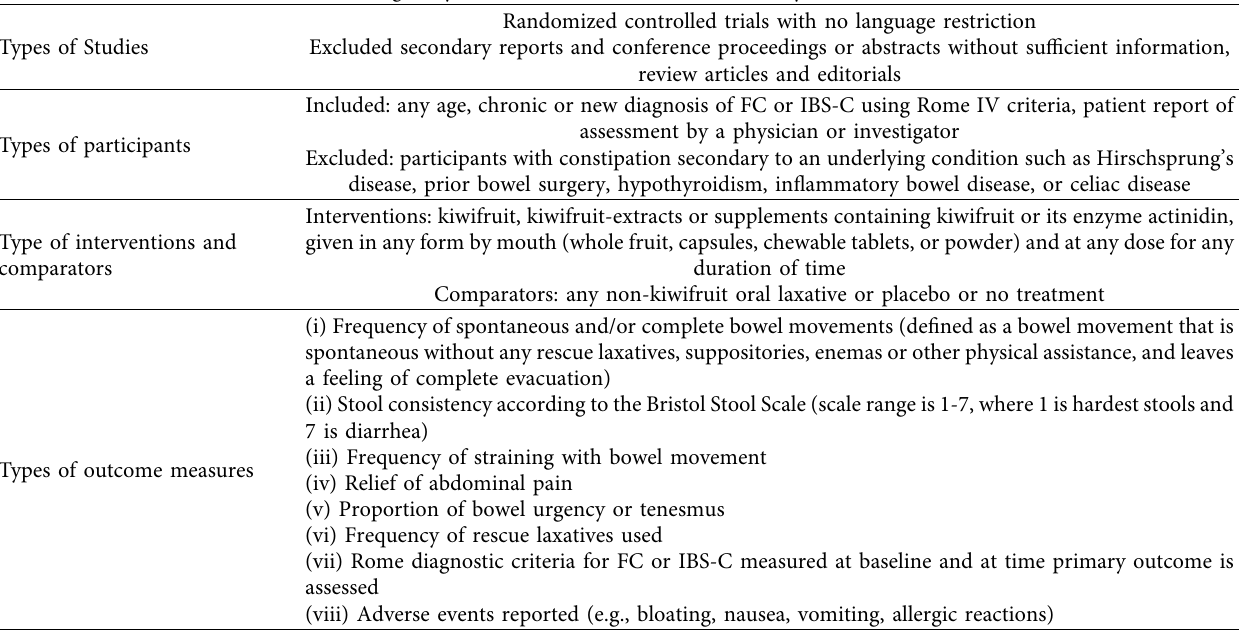
Table 1: Eligibility criteria for studies included in the systematic